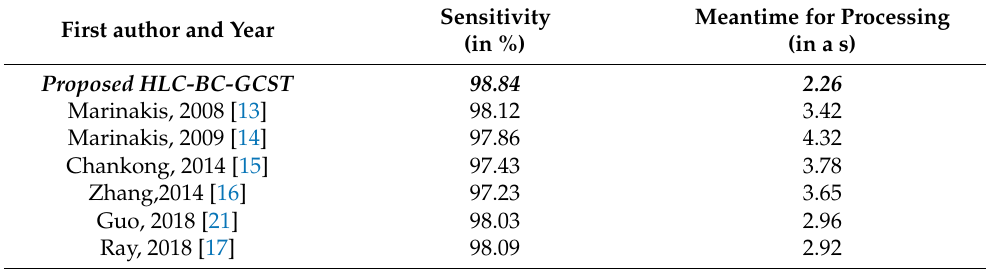
Table 2. Comparative performance: sensitivity and mean processing time.